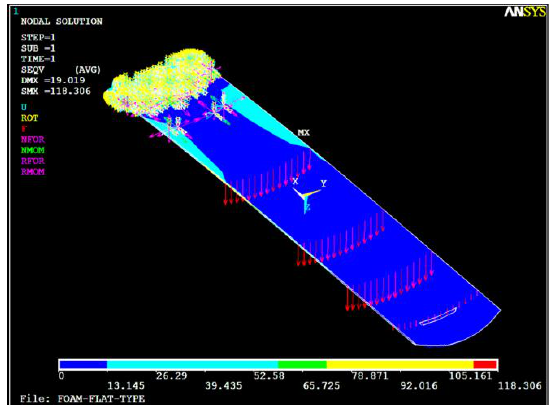
Figure 9. Result for structural analysis of sandwich cradle.